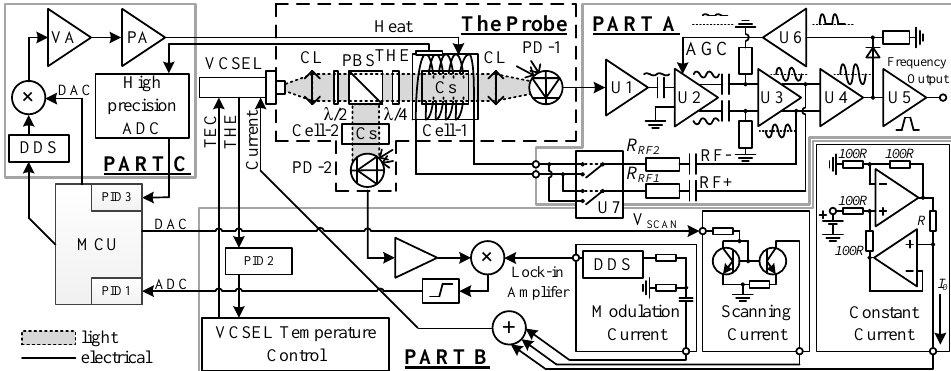
Figure 1. The structure of the portable self-oscillating VCSEL-pumped Cs atomic magnetometer.